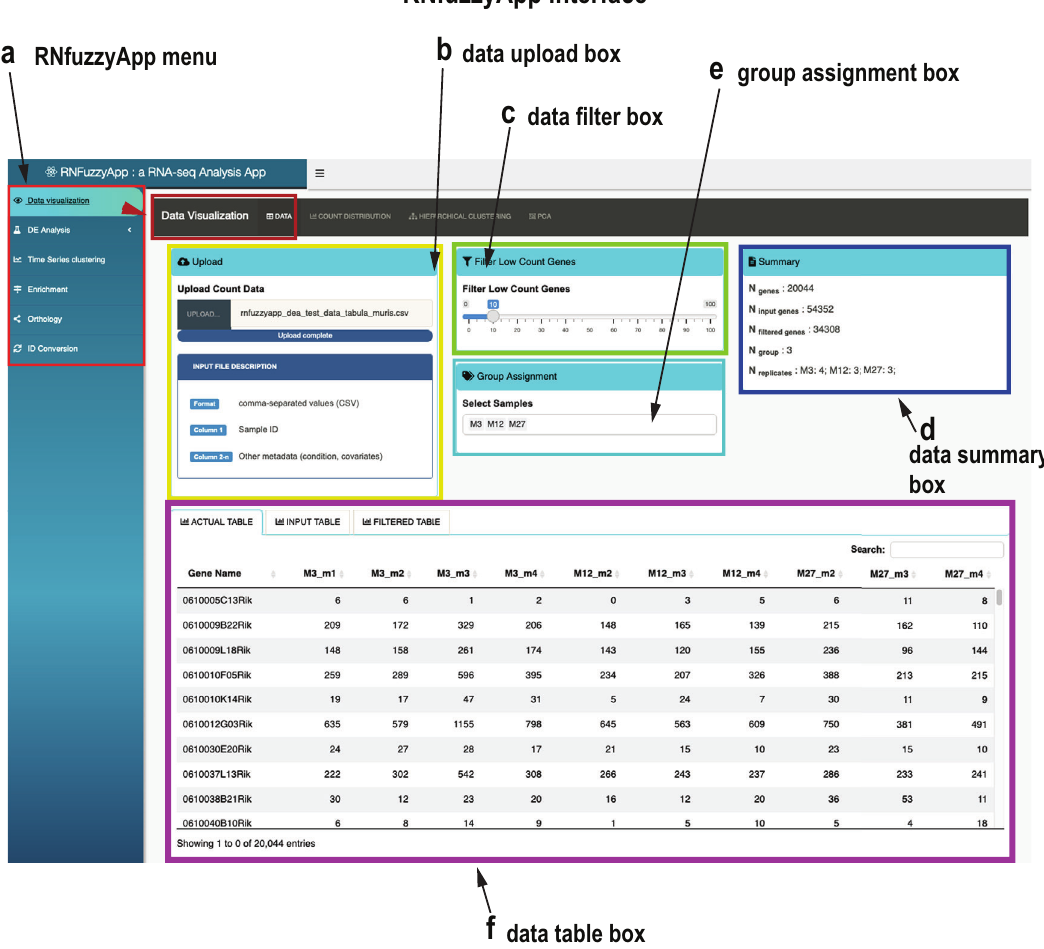
Figure 2. RNfuzzyApp start interface. (a) The RNfuzzyApp menu box is highlighted in red. This box is shown consistently over all interfaces and links to Data visualization, DE analysis, Data normalization and analysis, different visualization possibilities (MA plot, Volcano plot, Heatmap and PCA), Time series clustering (using the pipeline for Mfuzz soft clustering), Enrichment analysis, Orthology assignment, as well as ID-conversion. The main interface shown here belongs to Data visualization (highlighted in dark red). (b) Data upload box, for upload of user-provided data. (c) Data filter box, in which the user can choose to filter out genes with low read counts, (d) in which the identified groups are listed (e.g. wild-type and mutant or different time-points). Group assignment is automatic, so thenameformatofthesampleshastofollowaspecificpattern.(e)Datasummarybox.Thedatashowninthisboxare updated and in case of filtering and are renewed on the fly. (f) Data table box. Three tables are provided: the actual table, including genes that were not discarded due to filtering; the input table, containing all data uploaded; finally the filtered table, containing genes that were removed due to